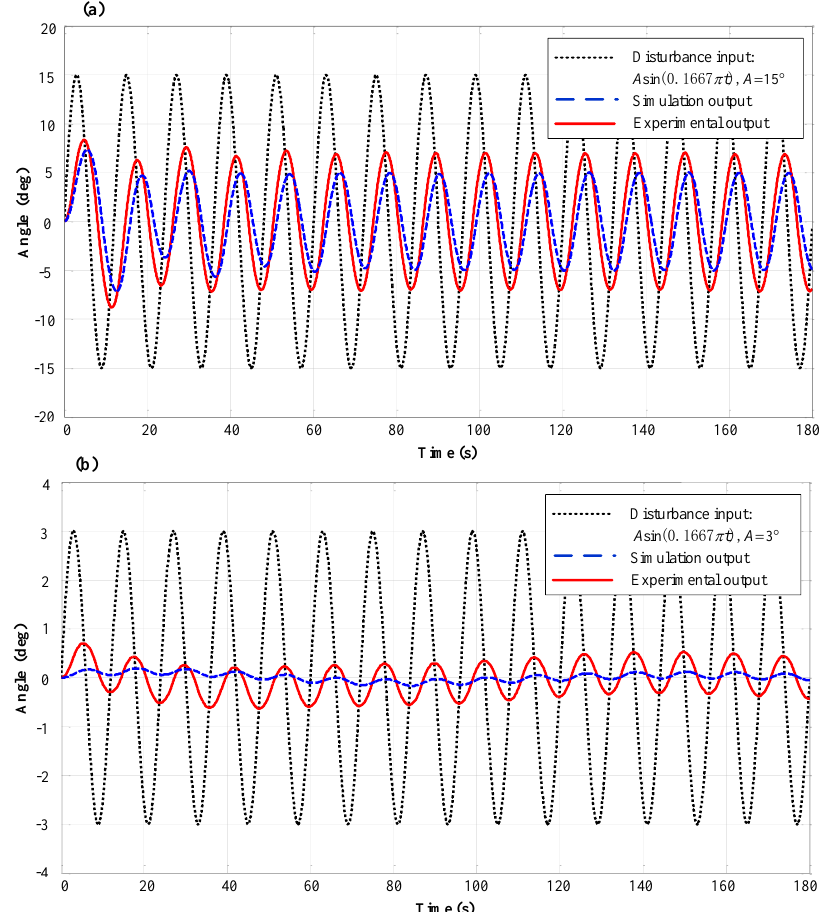
Figure 10. Simulation and experimental outputs at f = 0.0833. ( a ) A = 15°, simulation and experimental output; ( b ) A = 3°, simulation and experimental output.